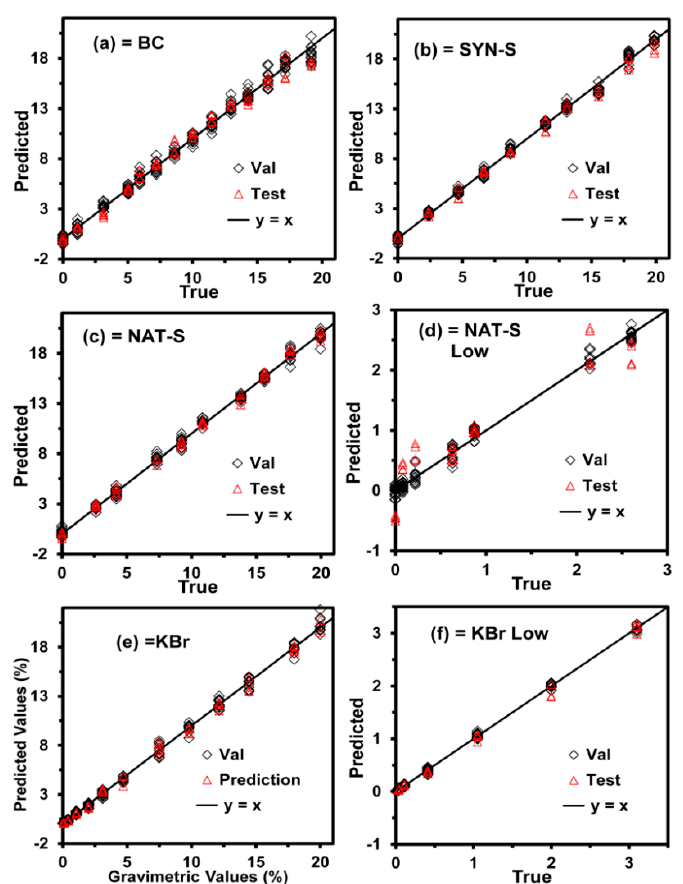
Figure 2. Predicted values vs. real values of % DNT from partial least squares (PLS) models on the matrices: ( a ) bentonite clay (BC); ( b ) synthetic soil (SYN-S); ( c ) natural soil (NAT-S); ( d ) NAT-S to low concentration (NAT-S Low); ( e ) potassium bromide (KBr) and ( f ) KBr to low concentration (KBr Low).